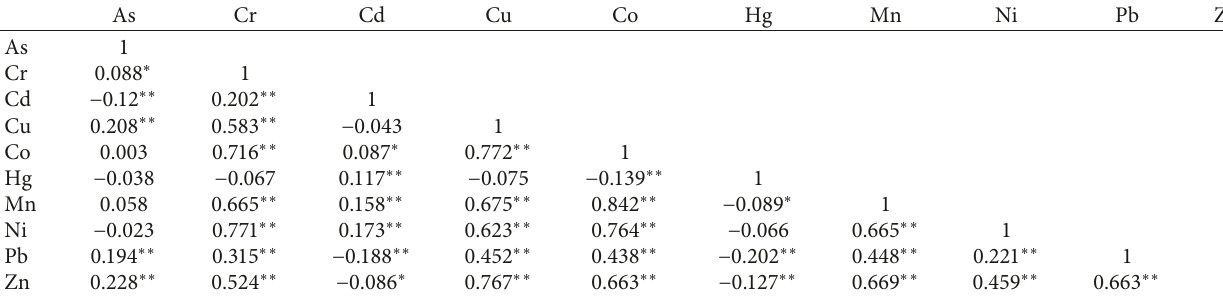
Table 4: Correction coefficients of ten heavy metals in the